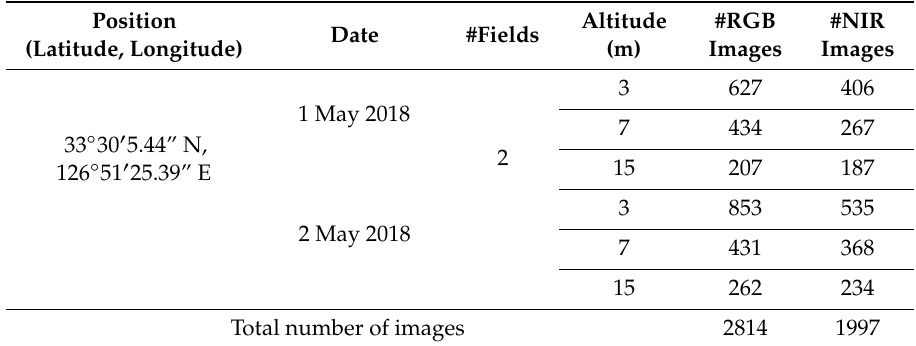
Figure 1. Sample images captured by unmanned aerial vehicle (UAV) at three di ff erent altitudes (3 m, 7 m, and 15 m). The top three images belong to the near-infrared (NIR) dataset, whereas the bottom three images are from the Red-Green-Blue (RGB) dataset. Table 1. Basic information of the proposed radish dataset (RGB + NIR) on Jeju, Korea (#Fields is the the number of fields, and #RGB Images is the number of RGB images, and #NIR is the number of NIR